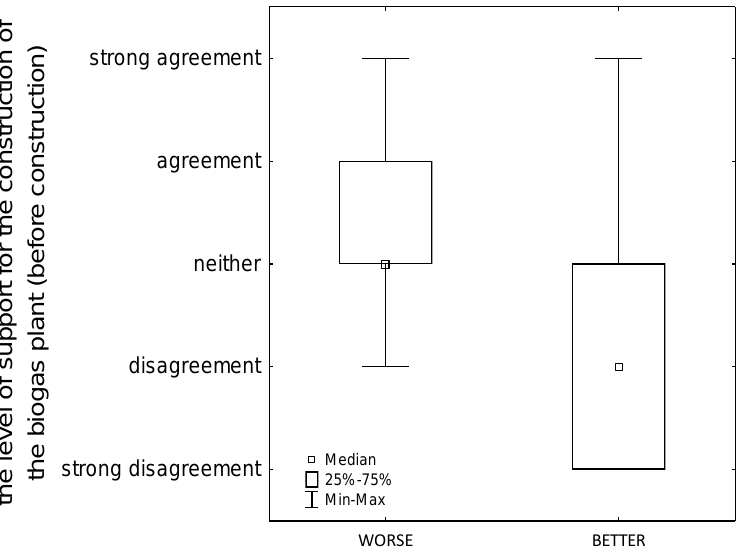
Figure 2. The level of support for the construction of the AD plant during its planning phase.